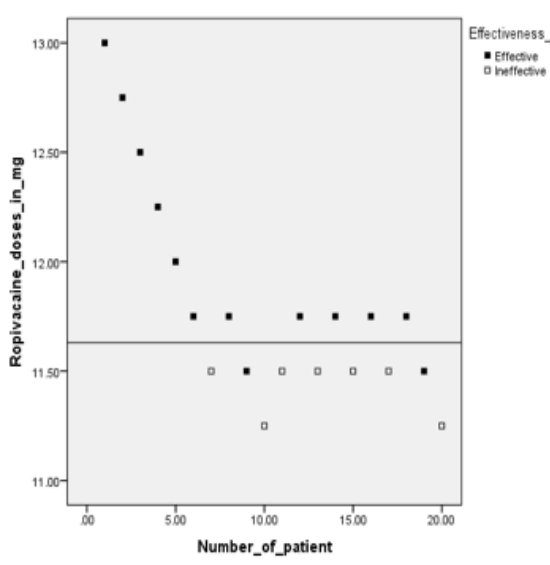
Figure 2. The MLAD of ropivacaine for caesarean section was 11.63mg (95%CI, 11.5-12.92) using the formula of Dixon and